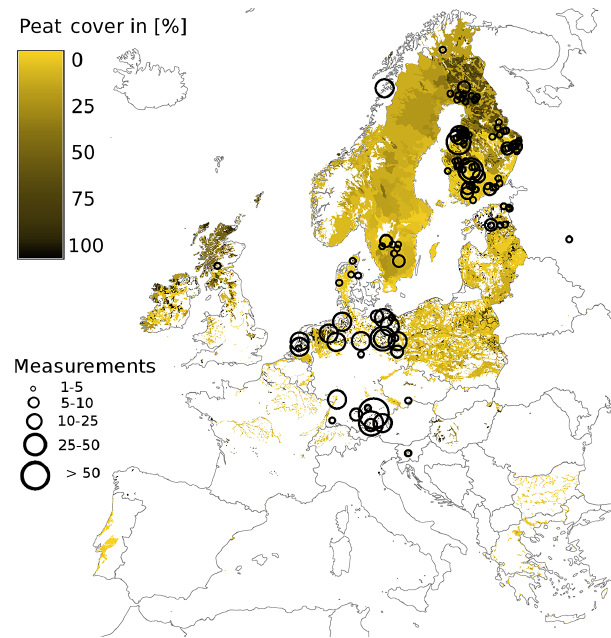
Figure 1. Overview for measurement sites. Size of points indicates number of measurements per site. Background map displays peat- land distribution in Europe with peat cover per square kilometre from Montanarella et al.